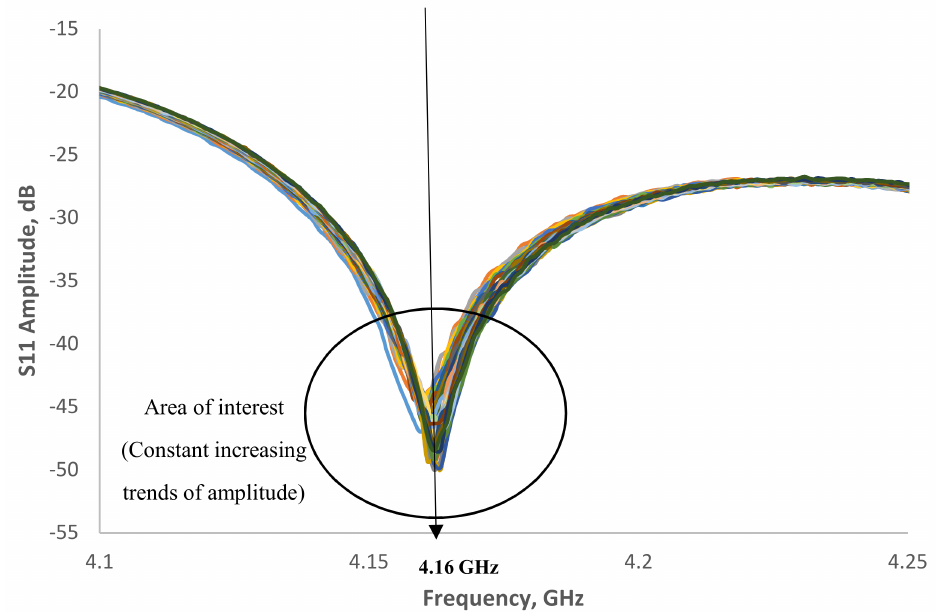
Figure 10. Signal spectrum for moisture content in EN 206-1-2013 concrete structure in the range of 4.1–4.25 GHz.